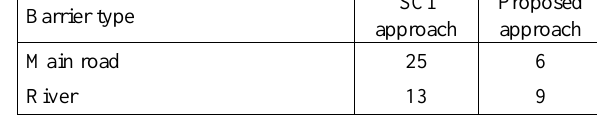
Table 4. Comparison of barriers